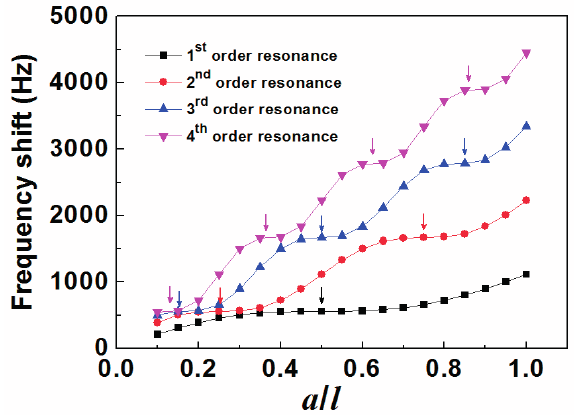
Figure 4. Mass load distribution ( a / l ) dependence of frequency shift of the magnetoelastic sensor under different order resonance